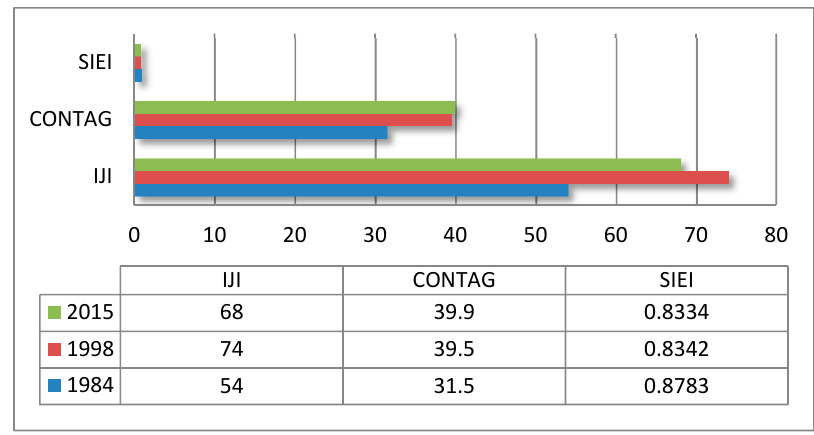
Figure 11. Interspersion and juxtaposition IJI, Contagion index (CONTAG), and Simpson’s evenness index (SIEI) for LULC changes of HSCZ 1984, 1998, and 2015 at landscape level.